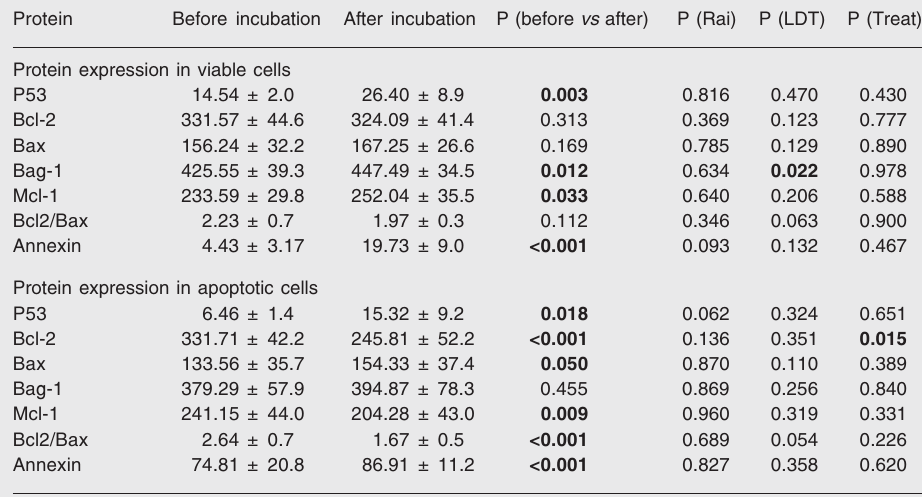
Table 2. Comparison of protein expression (MFI) before and after fludarabine incubation in viable and apoptotic cells. Protein Before incubation After incubation P (before vs after)